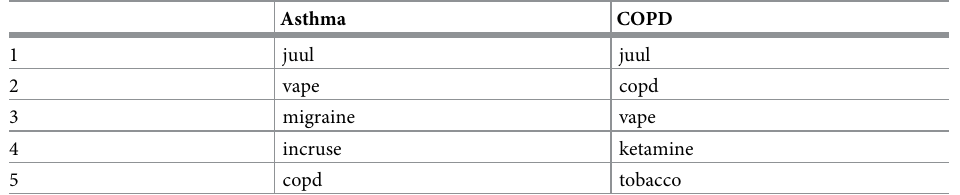
Table 3. Top 5 predictive search query terms for asthma and COPD